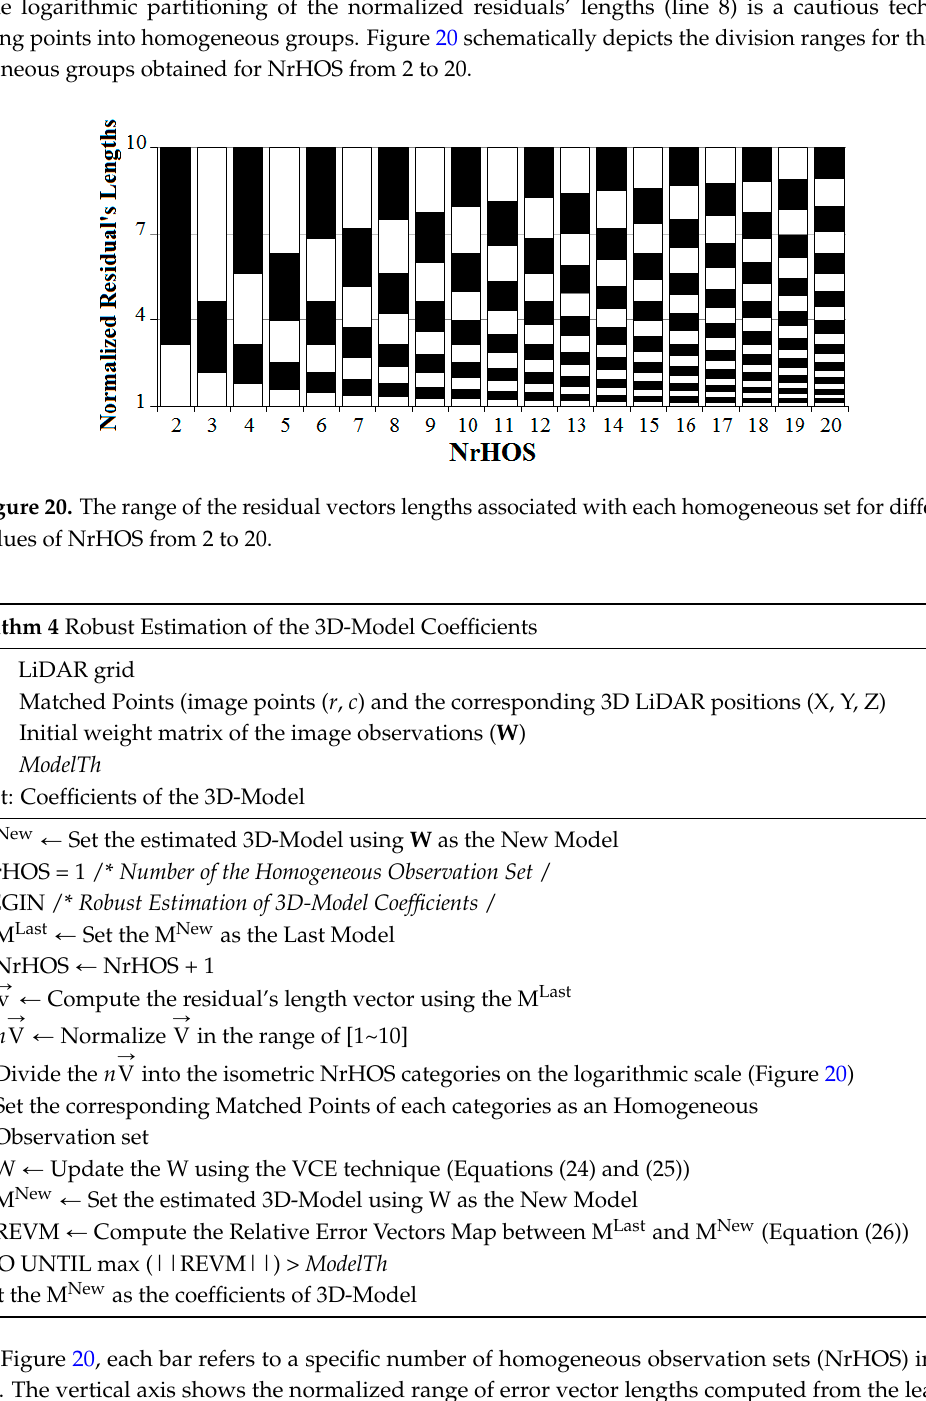
24 of 32 Algorithm 4 Robust Estimation of the 3D-Model Coefficients Input: